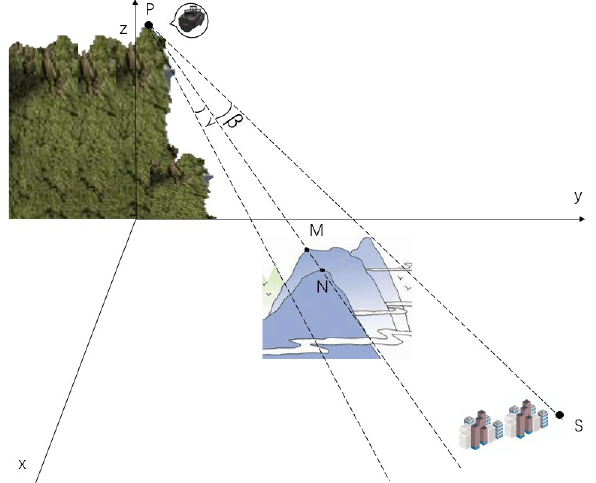
Figure 2. Optimal observation points based on Arcgis visual domain